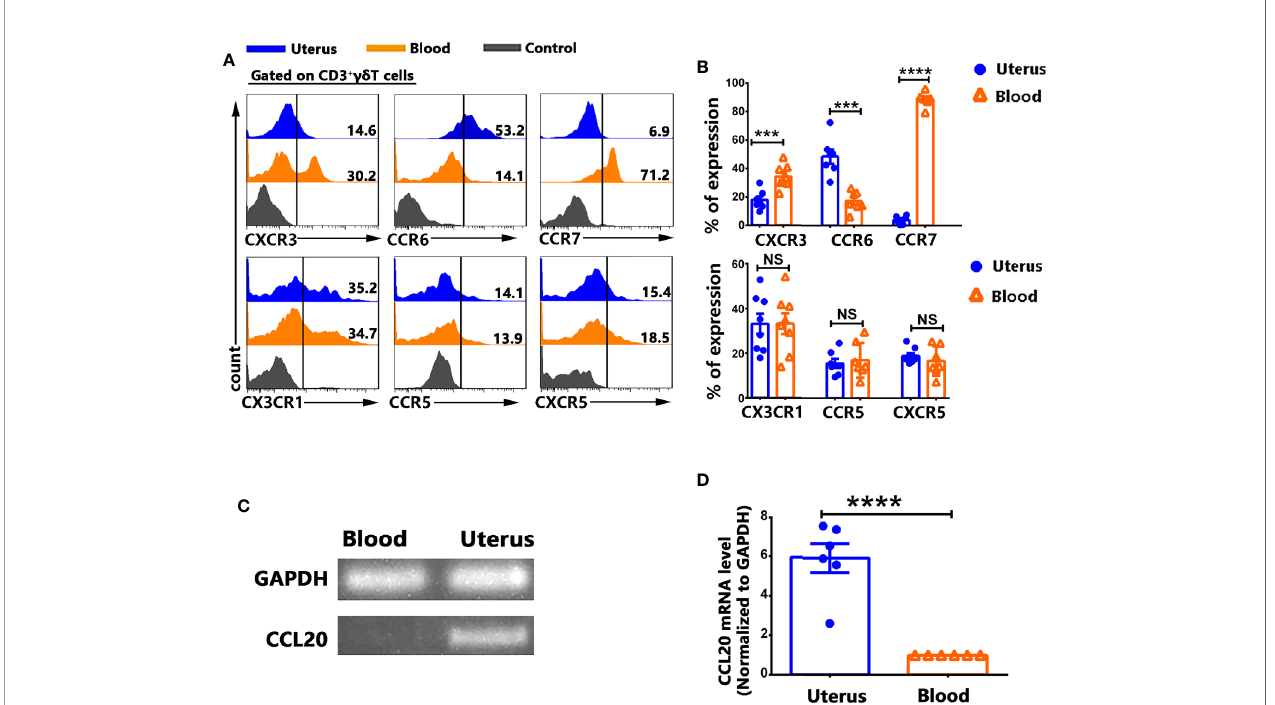
FIGURE 3 | gd T cells from uterus expressed higher levels of CCR6 and lower levels of CXCR3, CCR7 than gd T cells from blood. Uterus and blood mononuclear cells were stained with anti-CD3, gd T, CXCR3, CCR6, CCR7, CX3CR1, CCR5, CXCR5, and analyzed by fl ow cytometry. The cells were gated on CD3 + gd T + and the representative histogram graph for the expression of CXCR3, CCR6, CCR7, CX3CR1, CCR5, and CXCR5 were shown (A) . Statistical results (B) were from 6-8 independent experiments with six mice in each experiment. The levels of CCL20 and GAPDH mRNA in uterus and in blood were determined by RT-PCR (C) , and the ratio of CCL20 to GAPDH were quanti fi ed by densitometry (D) . Data were shown as mean ± SEM. The statistical signi fi cance was determined with the Mann – Whitney U test. NS, no signi fi cance, ***P < 0.001, ****P <